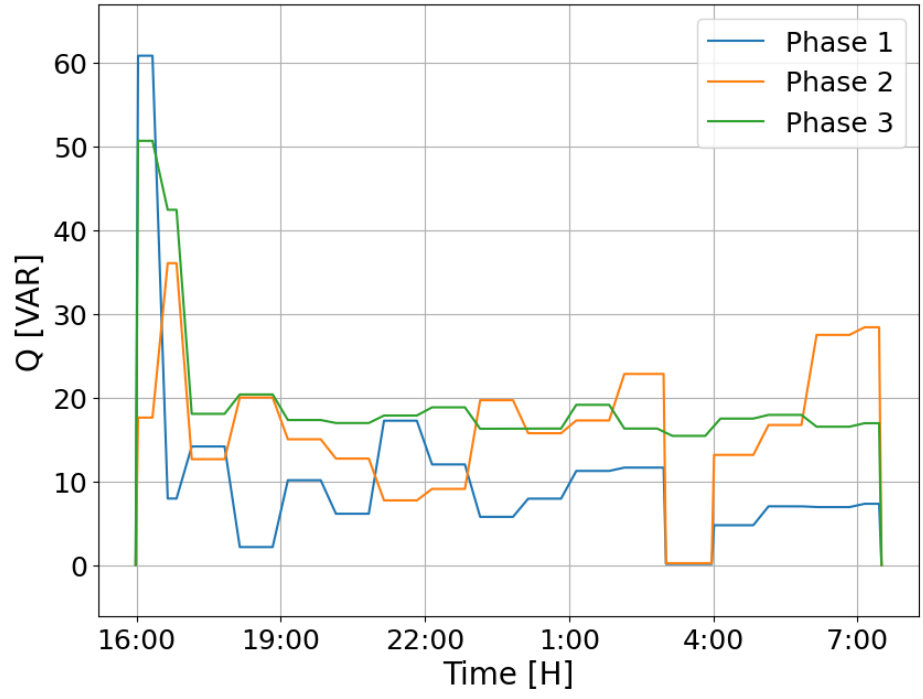
Figure 8. Characteristic of changes in reactive power values—luminaires with discharge sources (without reduction). Source: own study.